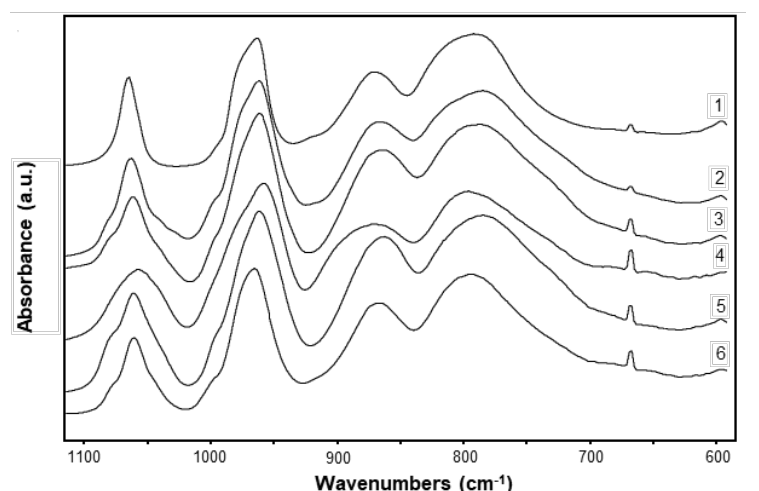
Figure 1. DRIFT spectra of HPA-n (powdered in KBr): HPA-0 ( 1 ), HPA-1 ( 2 ), HPA-2 ( 3 ), HPA-3 ( 4 ), Na-HPA-2 ( 5 ) and Cs-HPA-1 ( 6 ).